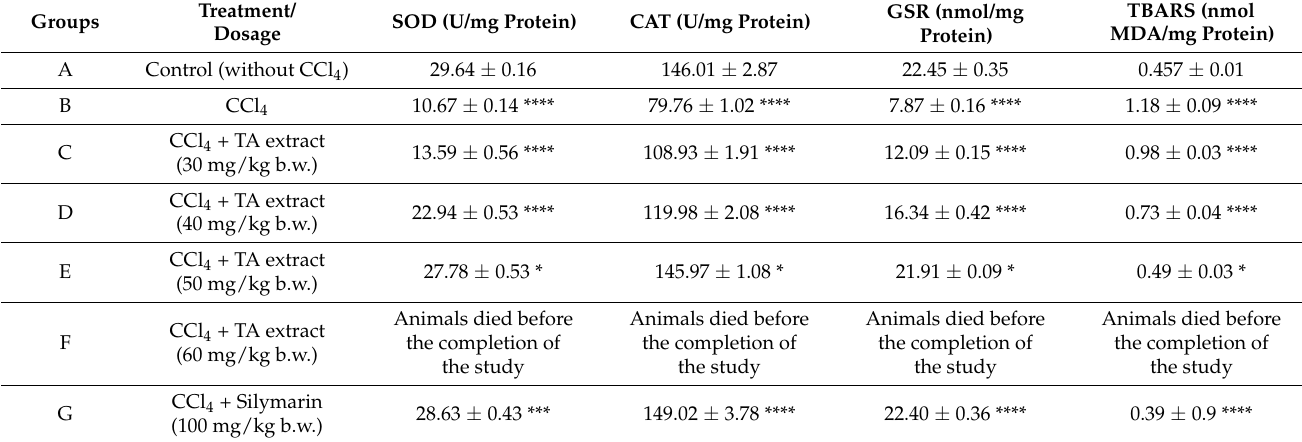
Table 4. Analysis of the antioxidant enzymes (SOD, CAT, GSR, and MDA) of liver tissues initially treated with CCl 4 to induce liver toxicity and treatment with varying doses of TA extract (30, 40, 50, and 60 mg/kg b.w.) along with standard silymarin (100 mg/kg b.w.). The data represent the mean value ± SEM of three independent experiments. * p < 0.05, *** p < 0.001, and **** p <